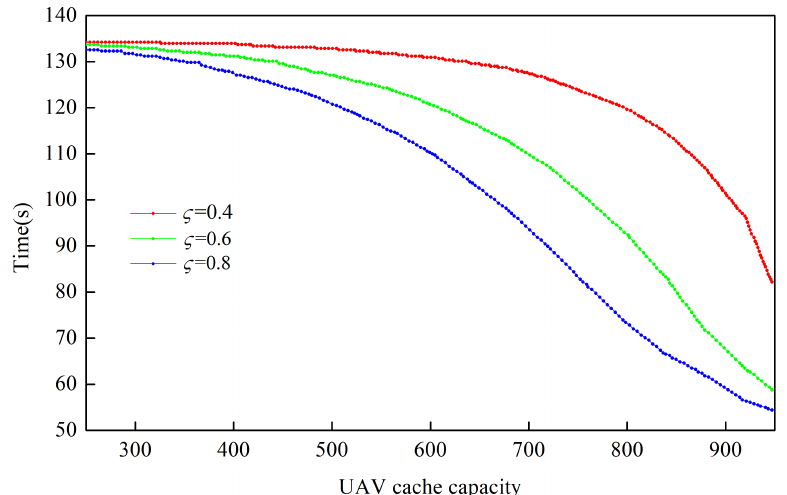
Figure 11. Effect of different ς values on UAV mission completion